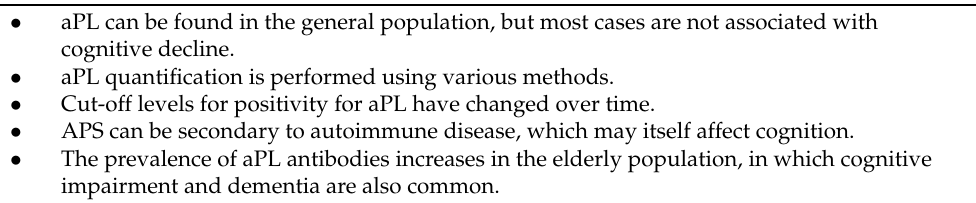
Table 1. Factors limiting the comparability across studies of cognitive impairment in aPL